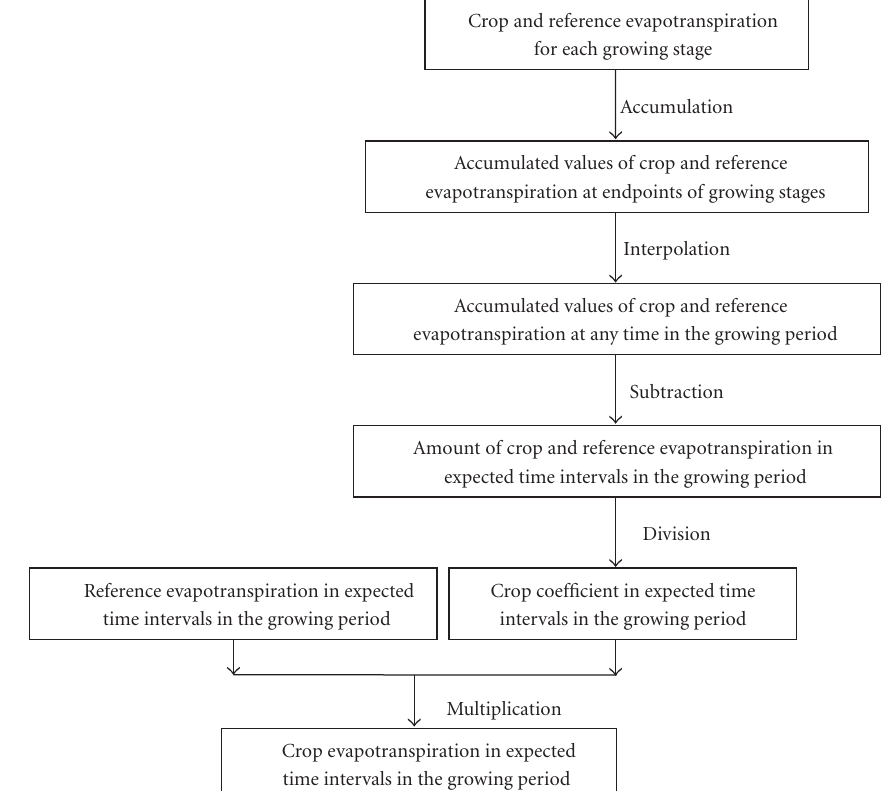
Figure 1: Proposed procedure to temporally downscale crop coe ffi cient and crop water